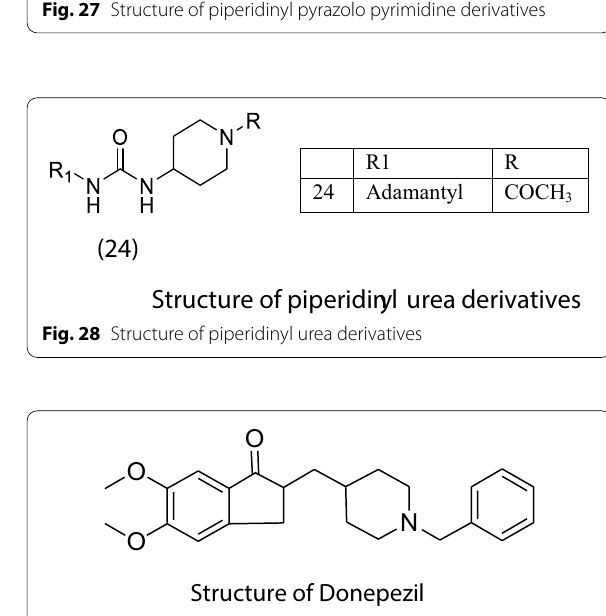
Fig. 27 Structure of piperidinyl pyrazolo pyrimidine derivatives